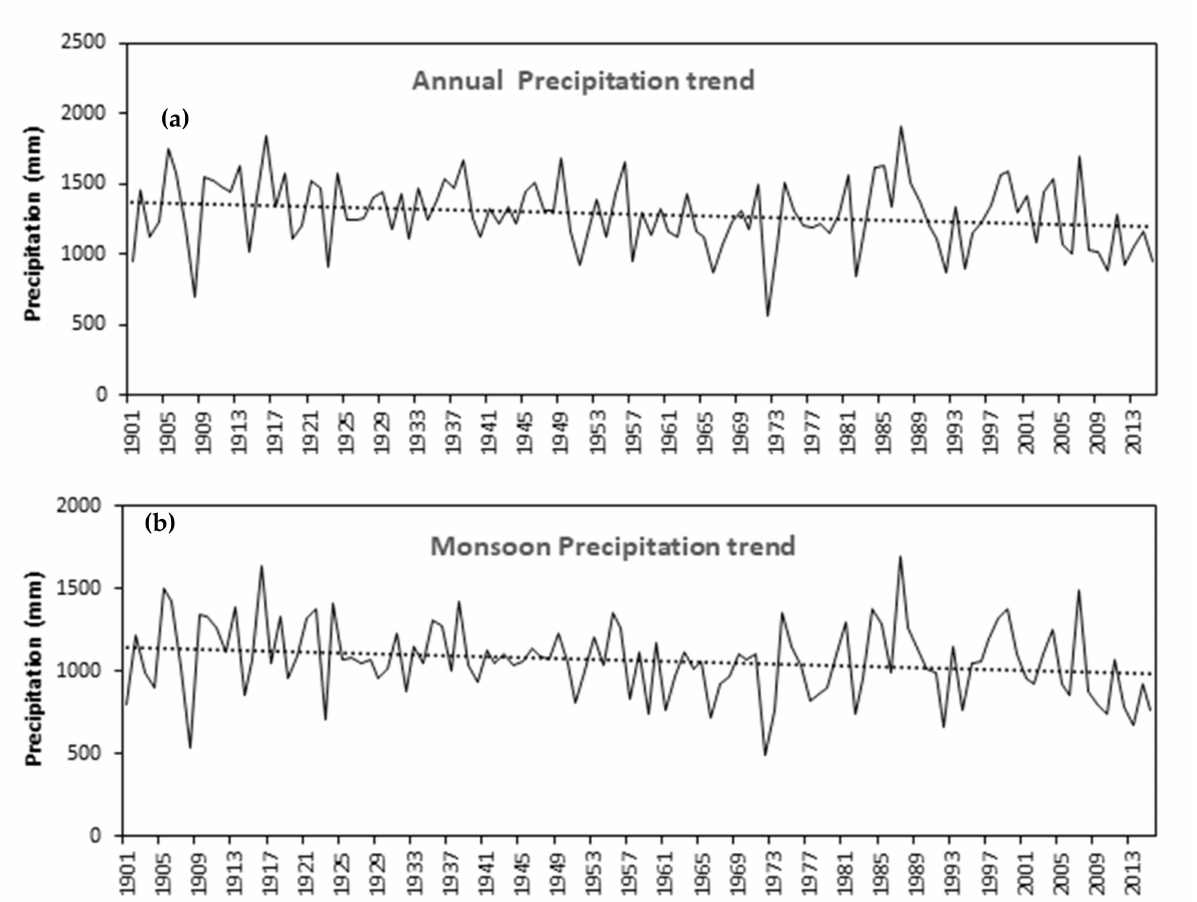
Figure 3. Temporal distribution of ( a ) annual precipitation and ( b ) monsoon seasonal precipitation of